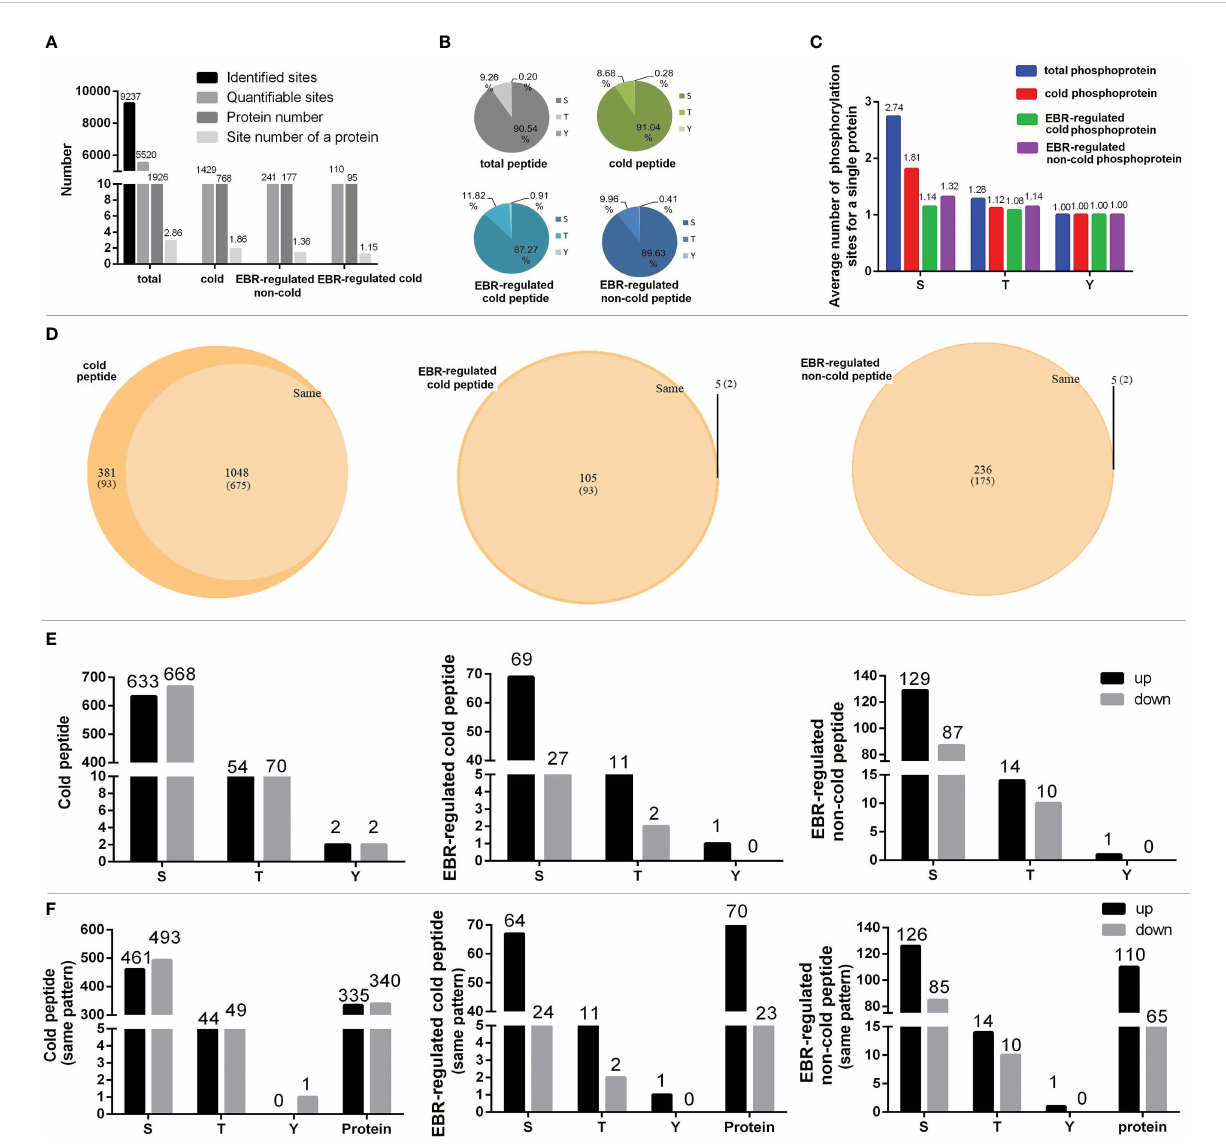
FIGURE 3 Analyses of phosphorylation patterns in cold-responsive phosphopeptides, EBR-regulated cold-responsive phosphopeptides, and EBR-regulated non-cold-responsive phosphopeptides. (A) The phosphorylation site statistics; (B) proportional of Ser, Thy, and Tyr sites in differential phosphoproteins; (C) an average number of phosphorylation sites for a single protein; (D) proportional of “ same-pattern ” and “ different-pattern ” peptides in phosphoproteome; (E) the number of up- or downregulated differential Ser, Thr, and Tyr phosphorylation sites in the differential phosphopeptides; and (F) the number of up- or downregulated differential Ser, Thr, and Tyr phosphorylation sites in the differential